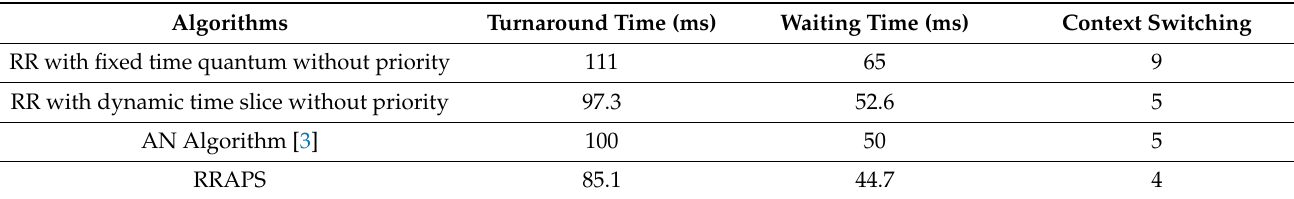
Table 1. Analysis of Case 1 between different algorithms.